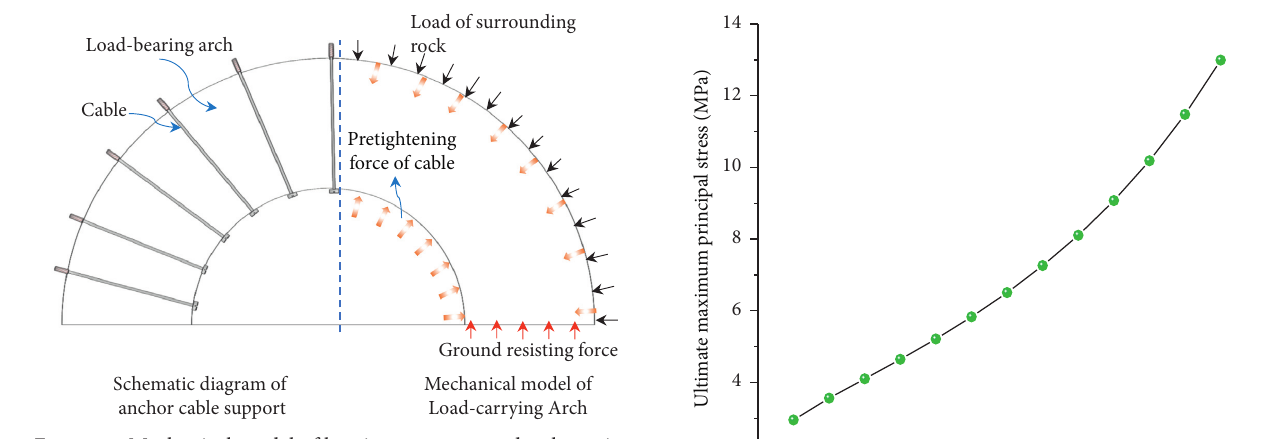
Figure 7: Mechanical model of bearing structure under the action of the prestressed cable.